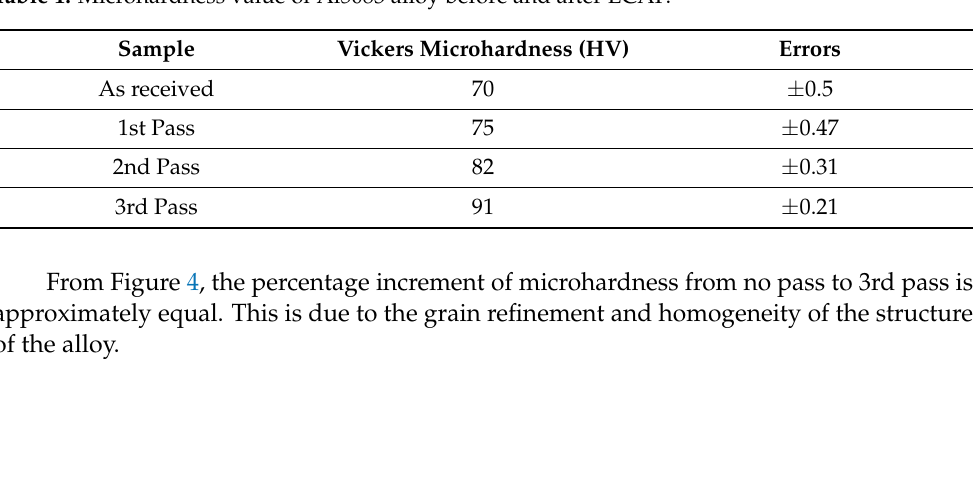
Table 1. Microhardness value of Al5083 alloy before and after